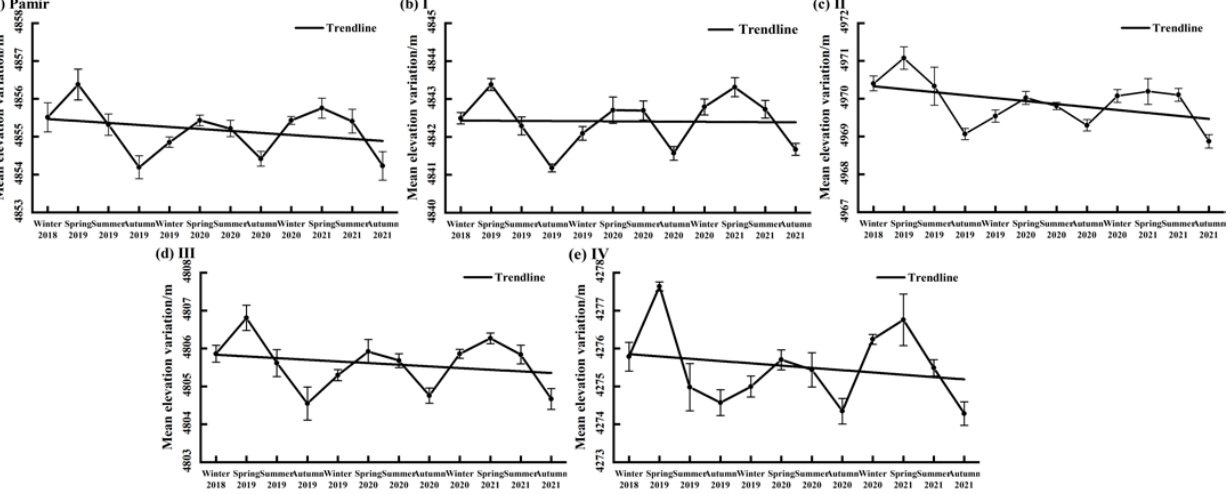
Figure 7. Seasonal glacier surface elevation variations in the Pamir glaciers from winter 2018 to